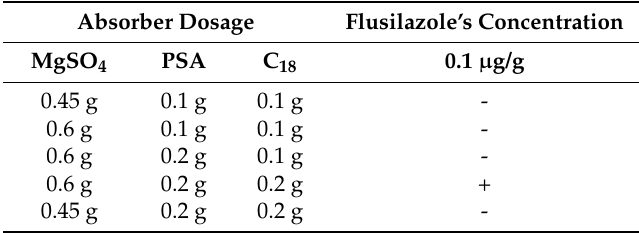
Table 2. Influence of three different amounts of sorbents on SERS detect of flusilazole.